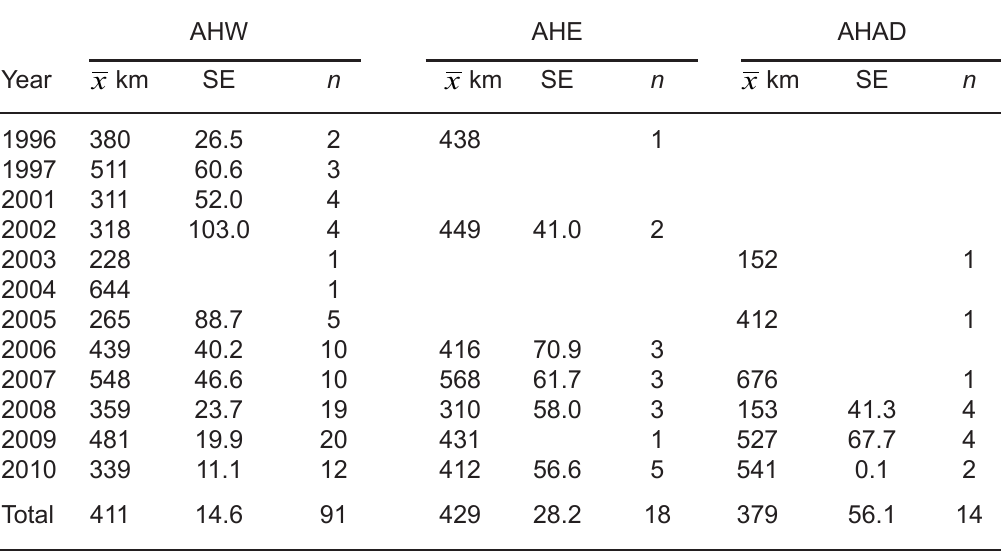
Table 5. Mean (standard errors) straight-line distances between calving and rut locations for collared cows that calved in either the Ahiak west (AHW), Ahiak east (AHE) and Ahiak Adelaide Peninsula (AHAD), blocks of the Queen Maud Gulf coastal calving area, 1996-2010.